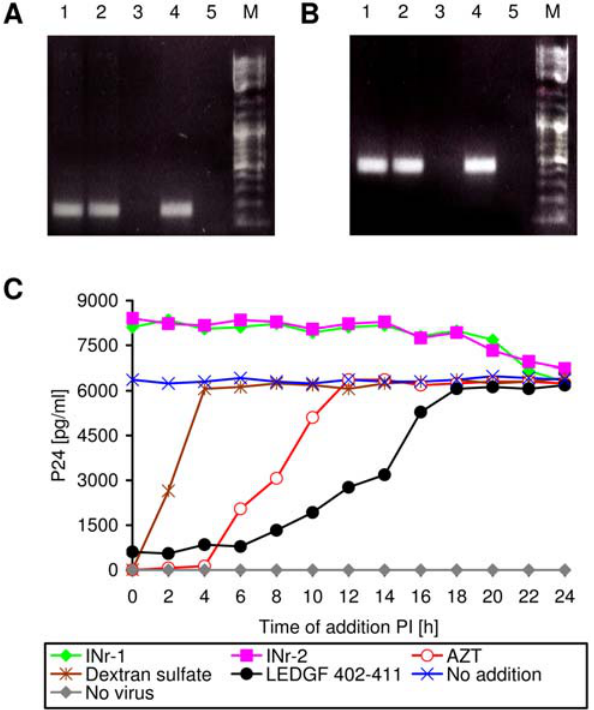
Figure 8. Virus-cell adsorption and viral reverse-transcriptase activity are not affected by the INr peptides. (A and B) Estimation of viral DNA in virus-infected cells: Sup-T1 cells were incubated with the indicated peptides or with AZT for 2 h and then were infected with HIV. Following another 6 h incubation, the viral Gag ( A) or Nef ( B ) DNA sequences were amplified using specific primers. The reaction was terminated after 30 cycles. Lanes: 1) INr-1 (12.5 m M); 2) INr-2 (12.5 m M); 3) AZT (2 m M); 4) untreated cells; 5) uninfected cells.